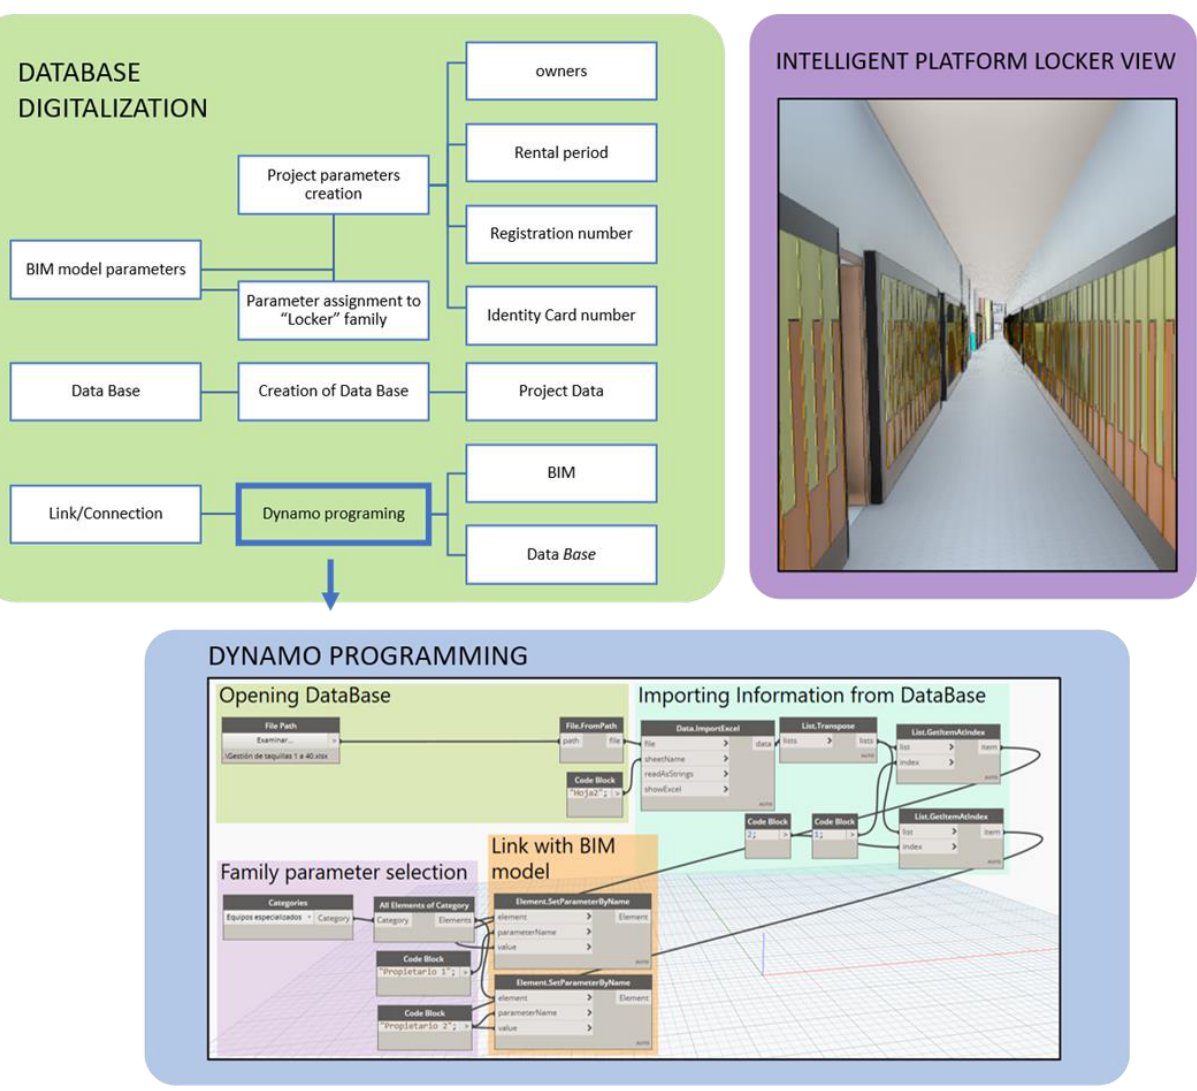
Figure 5. Locker management system linked with BIM with Dynamo programming.